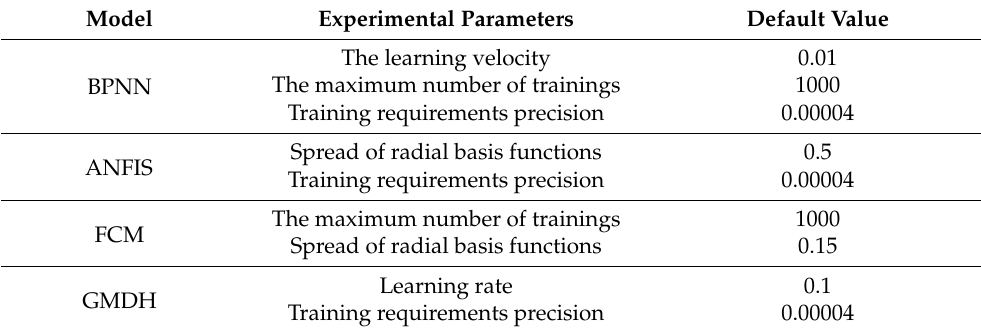
Table 2. Experiment parameters of artificial neural networks